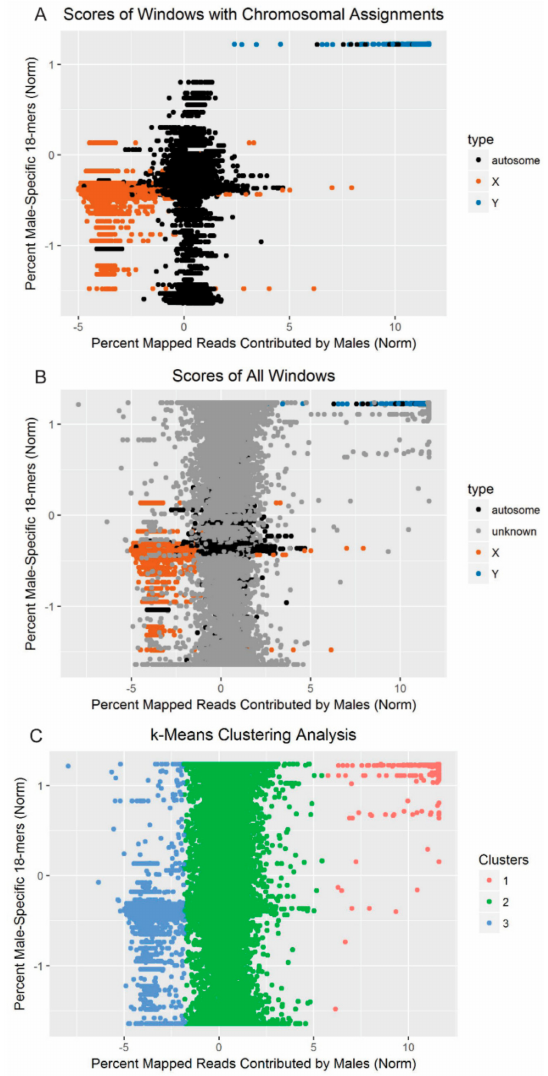
Figure 4. Based on copy number variation (CNV) between males and females and male-specific sequence motifs, the windows form three clusters. The percent of reads mapping to each window that originated in males (as estimated with CNV-Seq) was plotted against the percent of male-specific 18-mers comprising each sca ff old (as estimated with YGS.pl). Percentages were normalized based on standard score. ( A ) Windows from sca ff olds with predicted chromosomal origins are plotted, and chromosomal origin is indicated by color. ( B ) Windows from all 12,625 sca ff olds analyzed are included, and chromosomal origin, when known, is indicated by color. ( C ) Each window is color-coded according to the cluster to which it was assigned by k -means